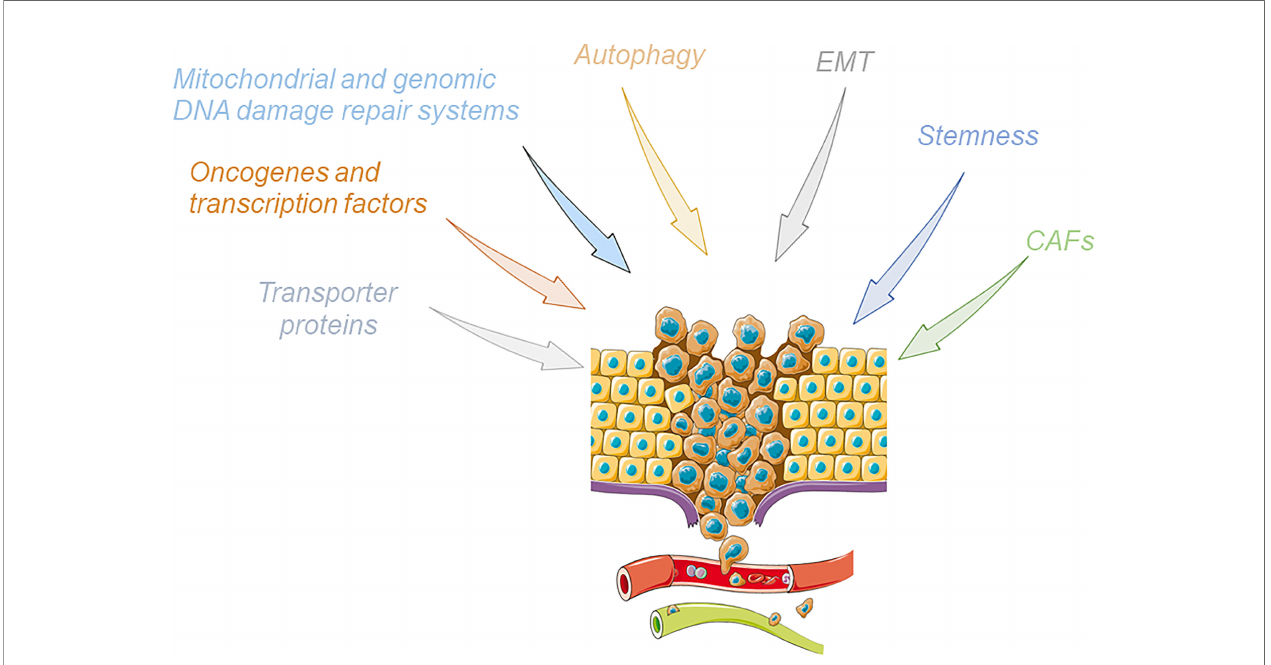
FIGURE 2 | Cartoon summarizing the main mechanisms involved in the induction of the phenomenon of tumor drug resistance. Upon the in fl uence of these pathways, drug-resistant cancer cells acquire an enhanced invasive ability, break away from the original tumor site, and fi nally metastasize to other organs through the blood or lymphatic systems. This fi gure was drawn with the support of the bioicons website